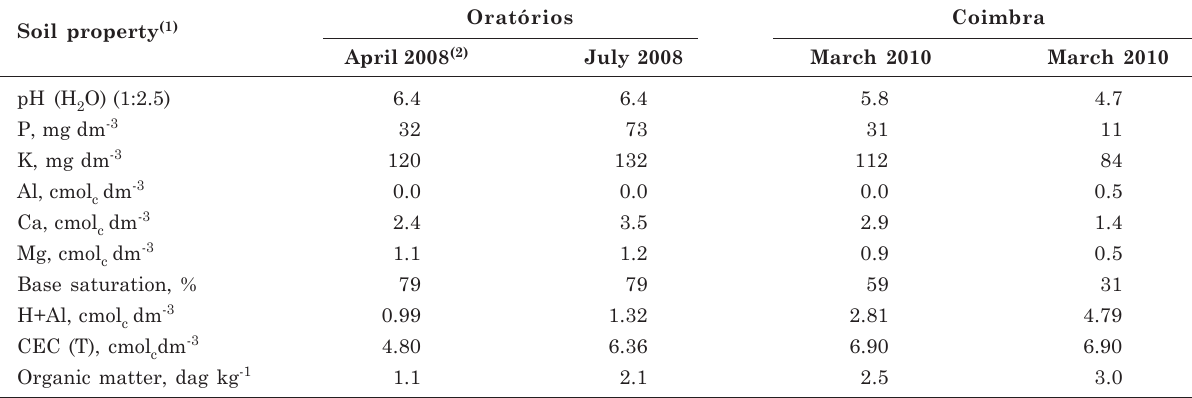
Table 1. Chemical characteristics of soils in the 0-20 cm layer in the experimental areas prior to the experiments